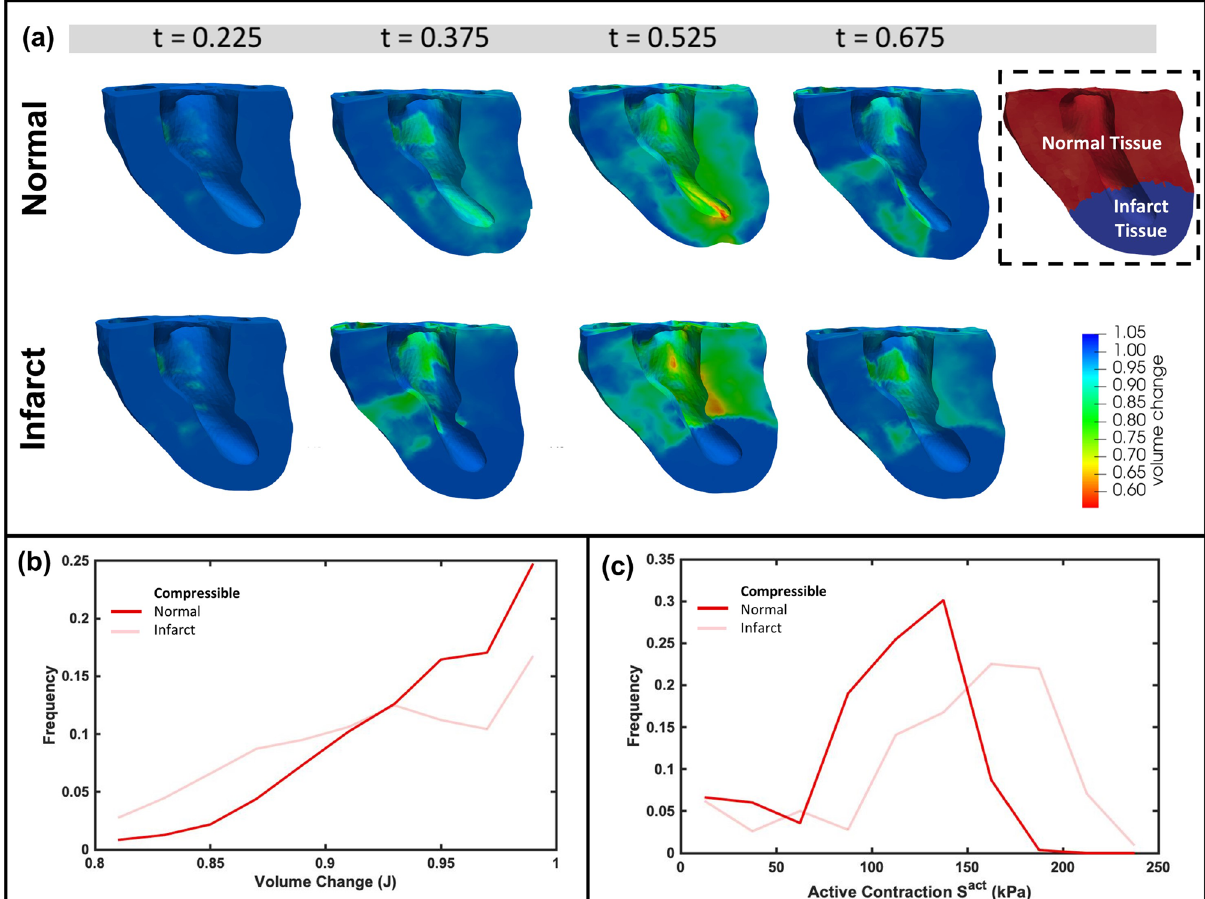
Figure 5. ( a ) Comparisons of volume reduction in one cardiac cycle between the normal and infarcted heart models, ( b ) distribution of spatial volume change within normal tissue from the normal and infarcted models, ( c ) distribution of spatial active contraction within normal tissue from the normal and infarcted models. All times t are normalized to cycle